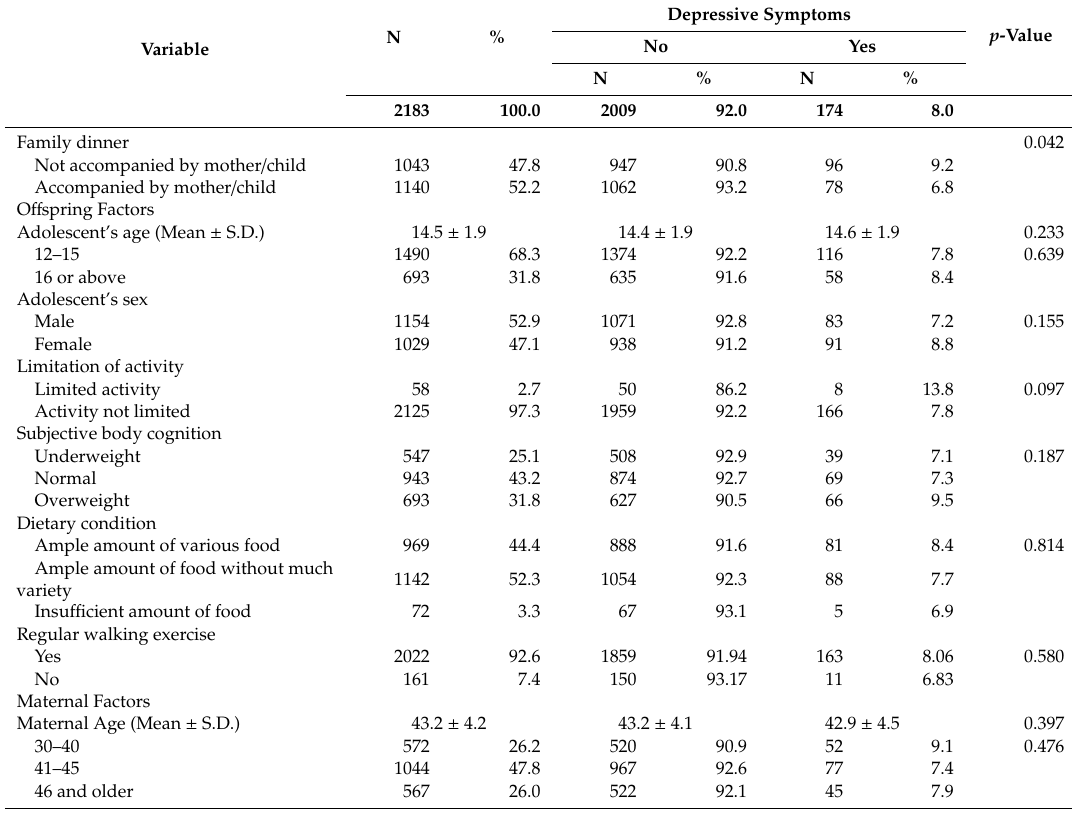
Table 1. General characteristics of adolescents aged 12–19 years and their mothers by depressive symptoms of the